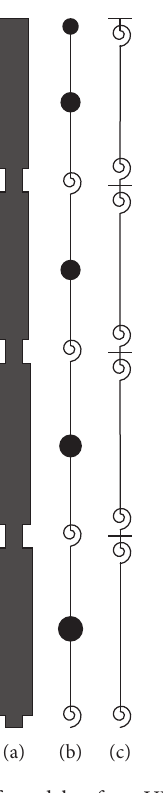
Figure 4: Three kinds of models of an UHV arrester: (a) non- uniform beam model, (b) mass-spring model, (c) analytical model in [25].